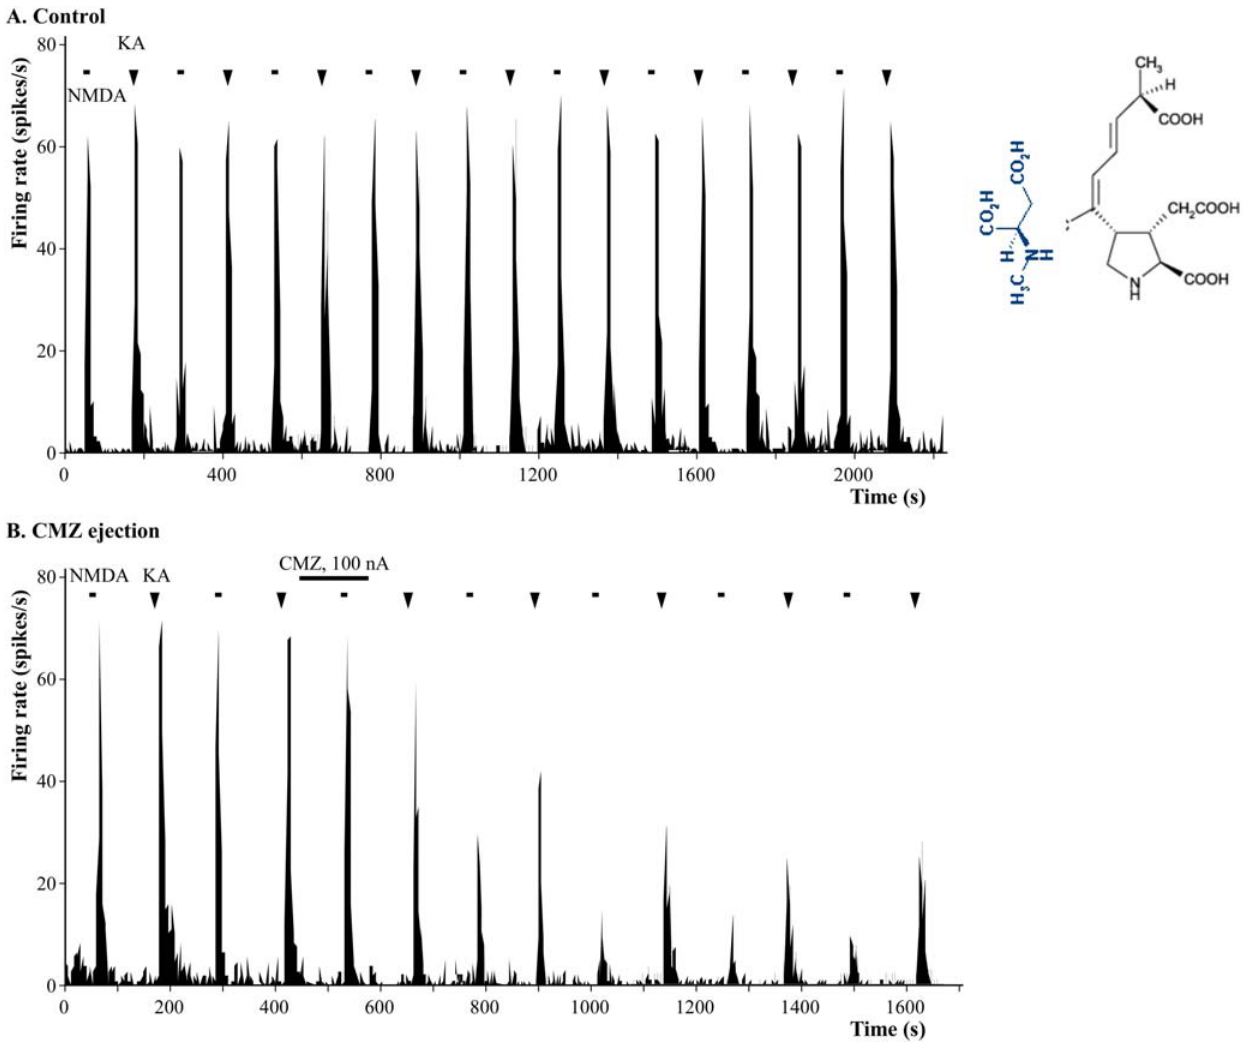
Figure 8. Calmidazolium (CMZ) differentially bocks NMDA-, and kainic acid (KA)-induced pain-responses. NMDA and kainic acid were iontophoresed, sequentially, 2 min apart using 2 85 nA and 2 30 nA, respectively, then calmidazolium was ejected as shown, which markedly inhibited the initial pain signals at the levels of dorsal horn neurons. Note the differential effects of calmidazolium on NMDA responses versus kainic acid responses. Panel A: Responses to NMDA and kainic acid iontophoresed alternately in every 2 min. Panel B: Effects of iontophoresed calmidazolium on the responses to these excitatory amino acids during the control period. Panel B: Differential effects of calmidazolium on the NMDA- versus the kainic acid-evoked responses. Similar results were obtained in fifteen additional experiments. A representative recording is